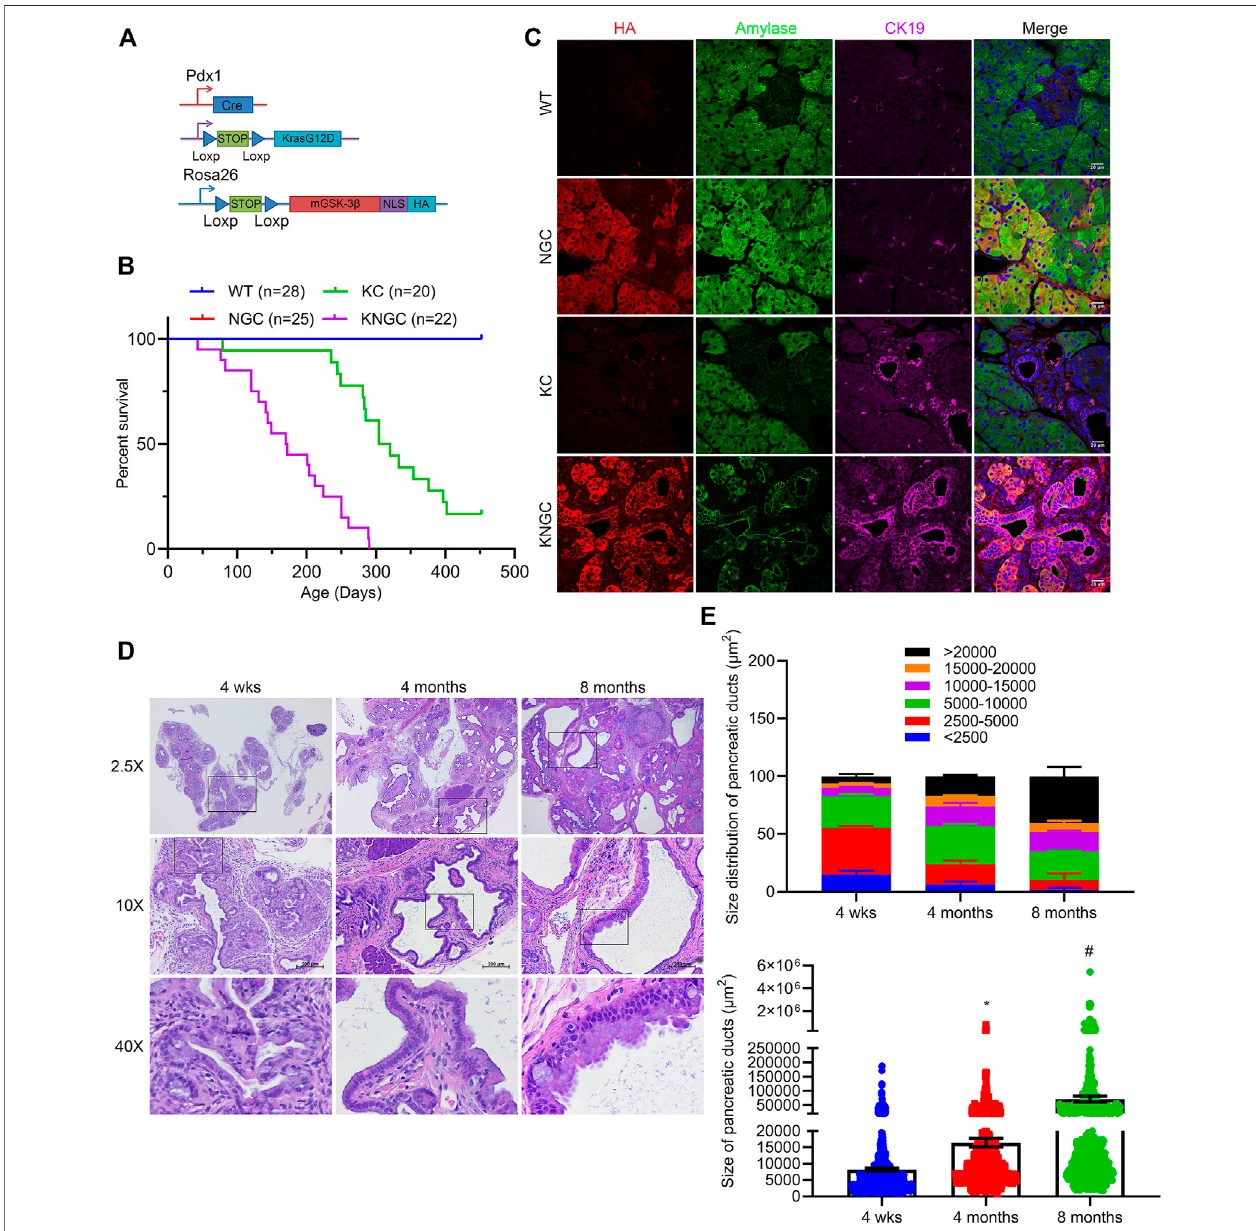
FIGURE 1 | Nuclear GSK-3 β and KRas G12D promote pancreatic ductal cell expansion and IPMN development. (A) Schematic representation of KNGC (LSL- KRas G12D /Rosa26-LSL-nuclear GSK-3 β /Pdx1-Cre) mouse model. Blue triangles indicate loxP sites. (B) Kaplan-Meier survival curve of the indicated genotypes. (C) Immuno fl uorescence (IF) staining of HA (red), amylase (green) and CK19 (purple) from pancreatic sections of indicated genotypes at 4 weeks age. Nuclei were counter- stainedwithHoechst(blue).Shownarerepresentativeimagefromthreedifferentmice. (D) H&E-stained pancreatic sectionsfromKNGCmiceof4-week,4-month, and 8-month. Black boxes indicate magni fi ed area. Bars = 200 μ m. (E) Quanti fi cation of pancreatic duct size distribution and distribution of pancreatic duct size for KNGC mice were analyzed and expressed as mean ± SEM. n = 5. p p < 0.05 4-month versus 4-week KNGC mice. # p < 0.05 8-month versus 4-month KNGC mice.